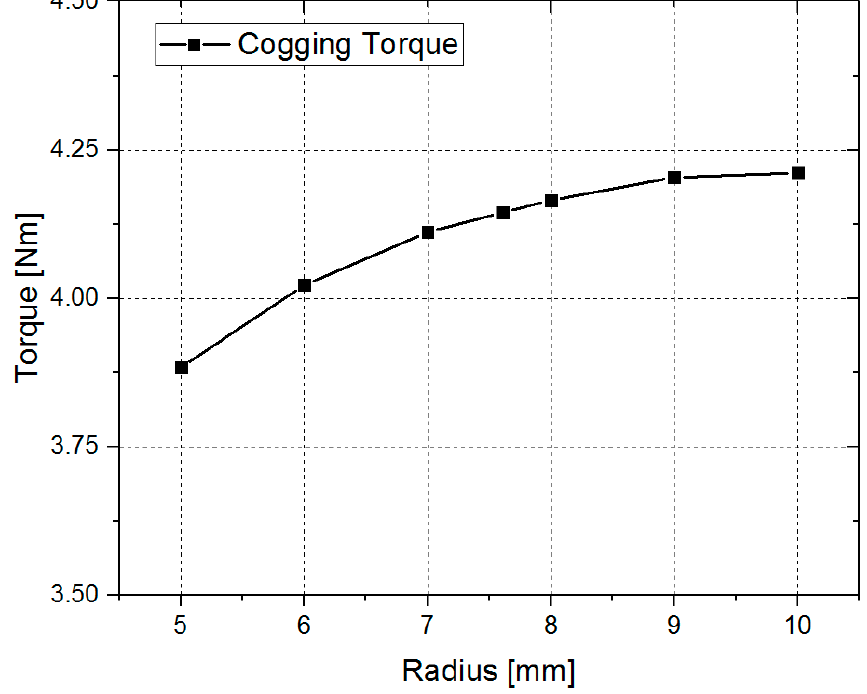
Figure 5. Comparison of cogging torque according to notch radius.